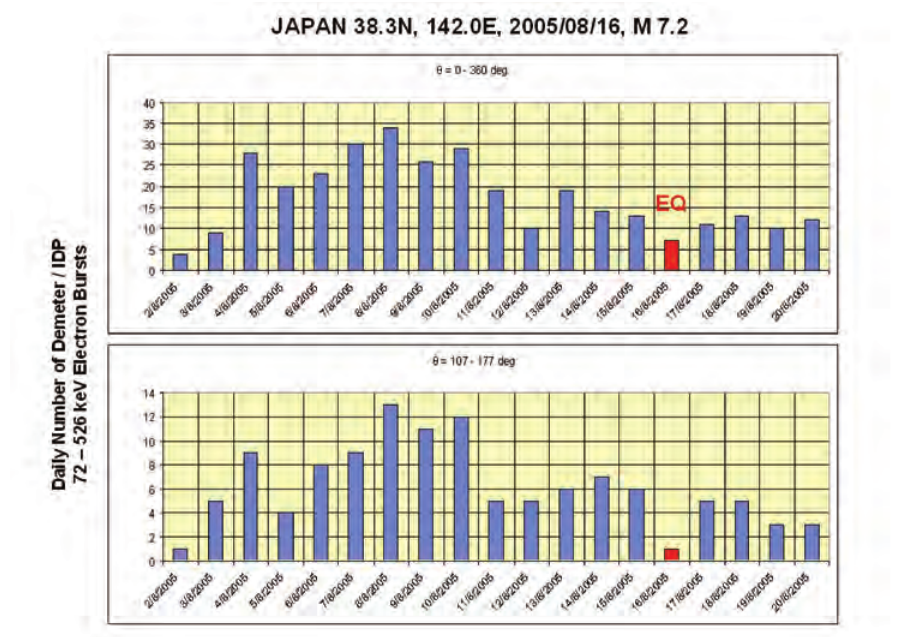
Figure 6. Temporal distribution of the daily number of EBs across the globe (top) and in a region extending ±35˚ eastwards and westwards of the epicenter longitude for the period August 2-20, 2005 including the day of a strong earthquake in Japan that occurred on August 16, 2005 (bottom). The correlation of the distributions is highly